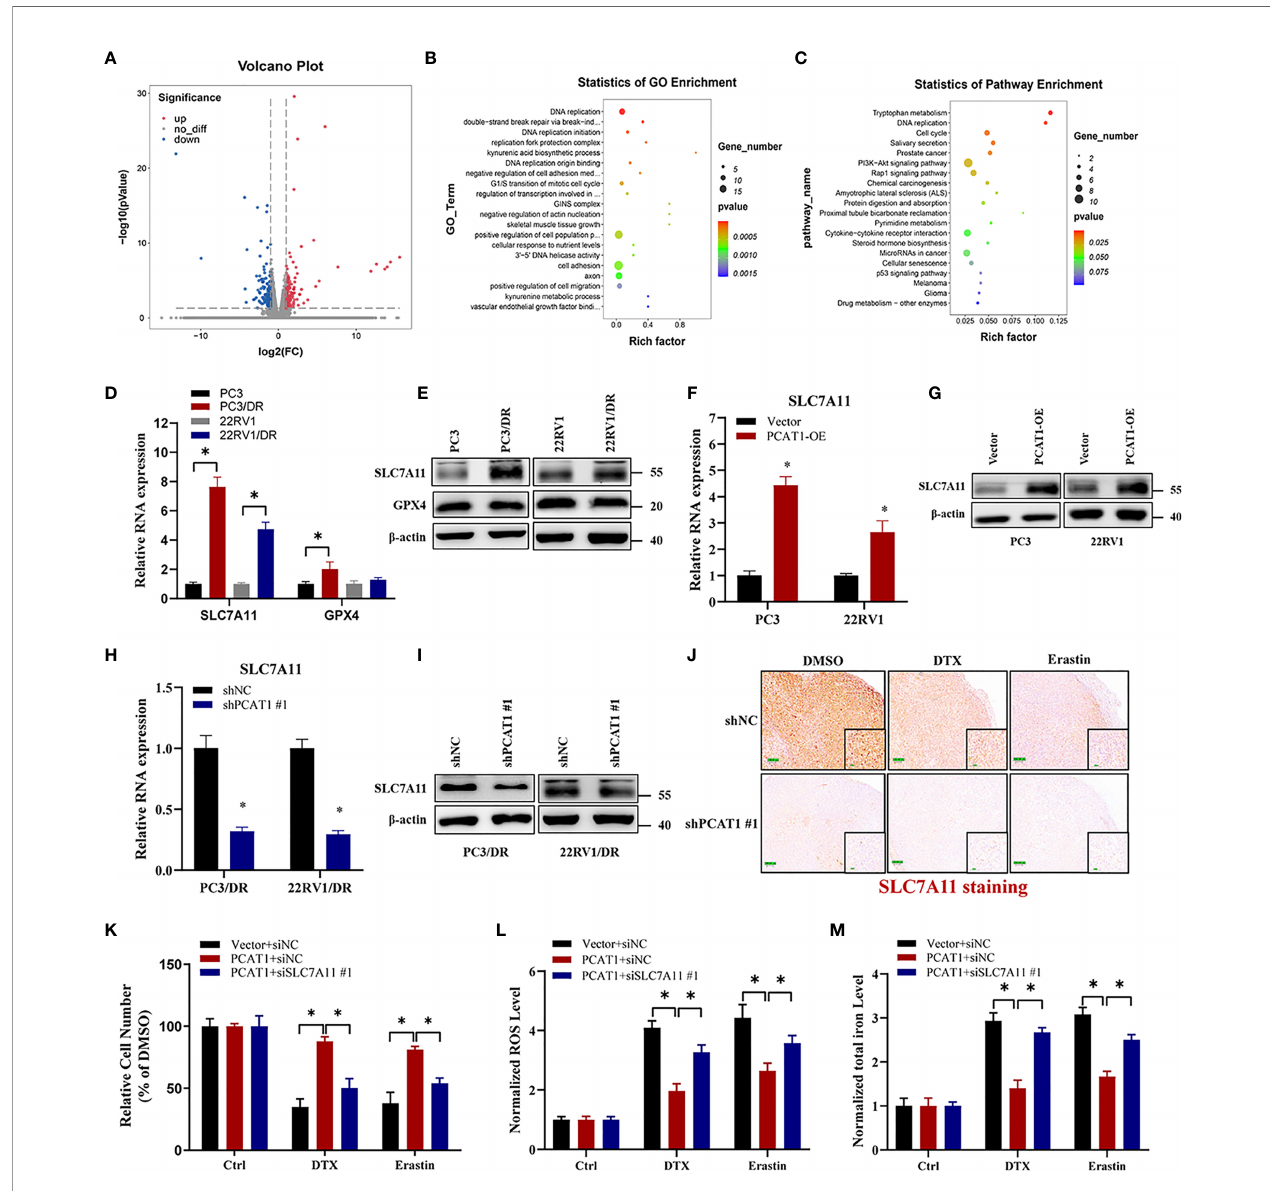
FIGURE 4 | PCAT1 mediates ferroptosis resistance by activating SLC7A11 expression. (A) The Volcano map representative the differentially expressed mRNAs in PC3/DR cells after PCAT1 knockdown. The red and green represent the upregulated and downregulated mRNAs. (B, C) GO and KEGG pathway analysis showed signi fi cant functional enrichment of DNA replication, double-strand break repair, oxidation-reduction process, drug metabolism and microRNA in cancer. (D, E) The mRNA and protein levels of SLC7A11 and GPX4 were evaluated by qRT-PCR and Western blot in DTX-resistant PCa cells (PC3/DR and 22RV1/DR) compared with their sensitive cells (PC3 and 22RV1). (F, G) The relative expression of SLC7A11 was evaluated by qRT-PCR and Western blot in PC3 and 22RV1 cells after PCAT1 overexpression, and (H, I) PC3/DR and 22RV1/DR cells after PCAT1 knockdown. (J) The expression of SLC7A11 was detected by IHC in xenografts mice model unpon PCAT1 knockdown. (K – M) The cell viability, lipid ROS content and total iron concentration were detected in PCAT1-overexpressed PC3 cells after co- transfected with si-SLC7A11 and control siRNA under DTX and erastin treatment. The data are presented as the means ± S.D. of at least three independent experiments. * P